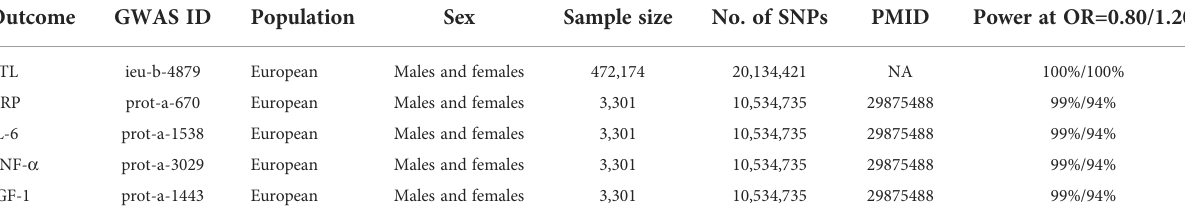
TABLE 1 Description of data source for each